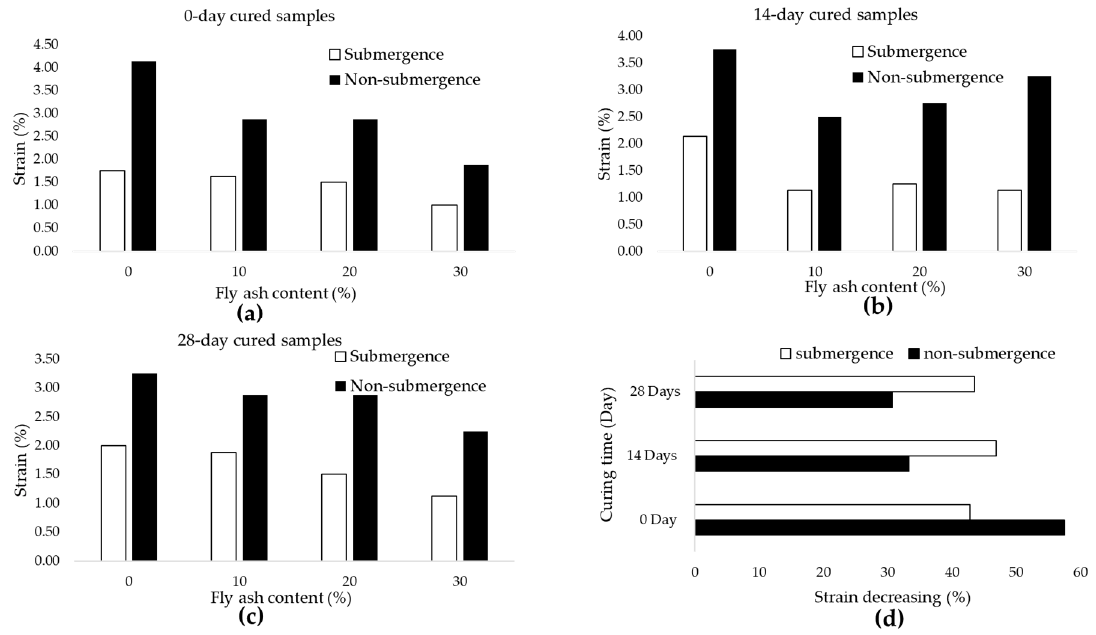
Figure 2. The influence of the variation in FASL specimen on strain at different curing times under non-submergence and submergence conditions: ( a ) zero days; ( b ) 14 days; ( c ) 28 days; and ( d ) strain increasing.